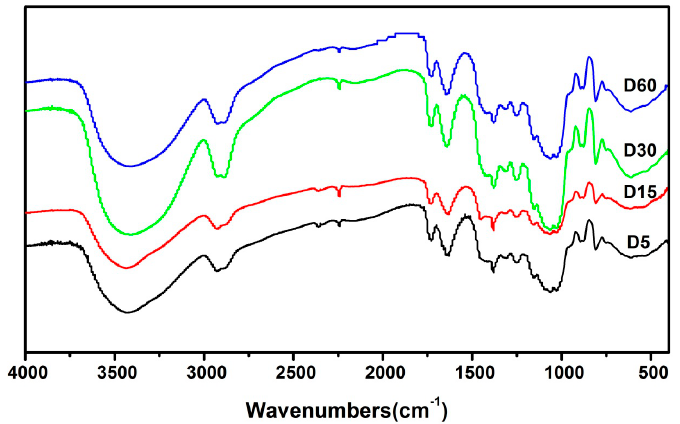
Figure 3. FT-IR spectra of KGM treated with different ultrasonic time (D5, D15, D30 and D60 was assigned to KGM prepared by ultrasonication for 5, 15, 30 and 60 min,